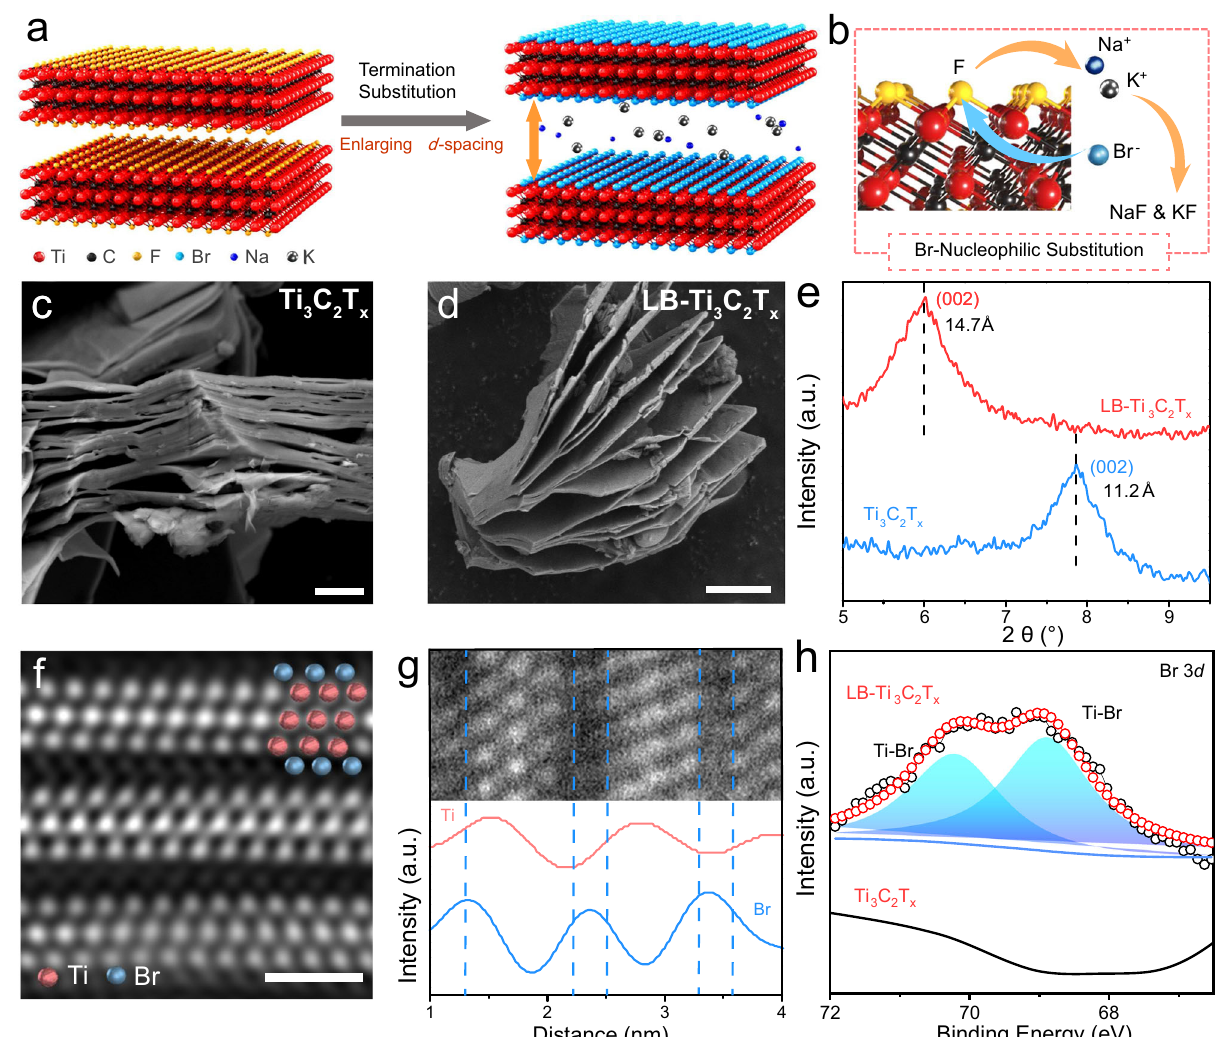
Fig. 1 | Preparation and characterization of LB-Ti 3 C 2 T x . a Schematic of the pre- paration of LB-Ti 3 C 2 T x . After Lewis-basic halides treatment, Ti 3 C 2 T x is intercalated by desolvated Na + and K + , inducing the increased interlayer spacing. Simulta- neously,thesurface-Fterminationisreplacedbydesolvatedhalogenanions. b The process of the nucleophilic substitution between desolvated Br - and F atoms (red balls: titanium, black balls: carbon, yellow balls: fl uorine, cyan balls: bromine, blue balls:sodium,silverball:potassium). c , d SEMofmultilayerTi 3 C 2 T x andLB-Ti 3 C 2 T x .